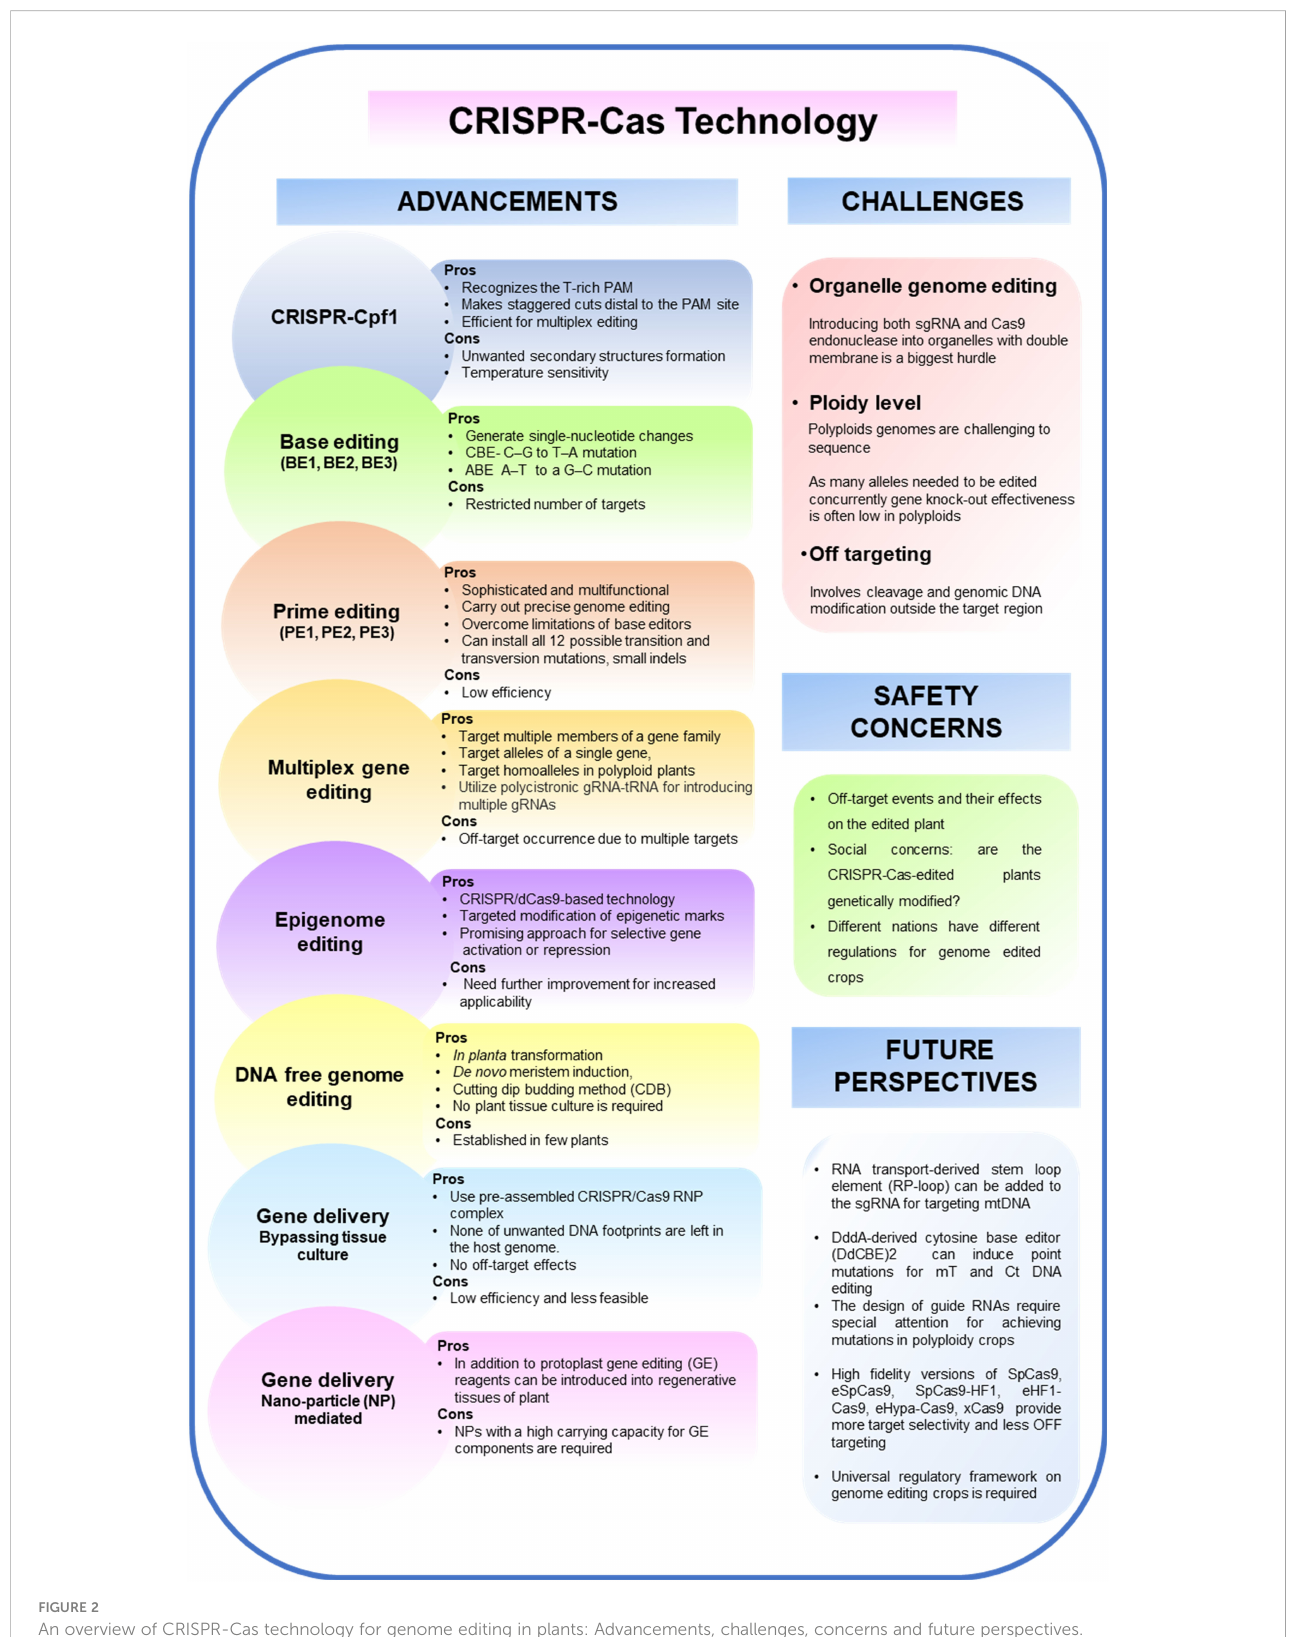
FIGURE 2 An overview of CRISPR-Cas technology for genome editing in plants: Advancements, challenges, concerns and future perspectives.